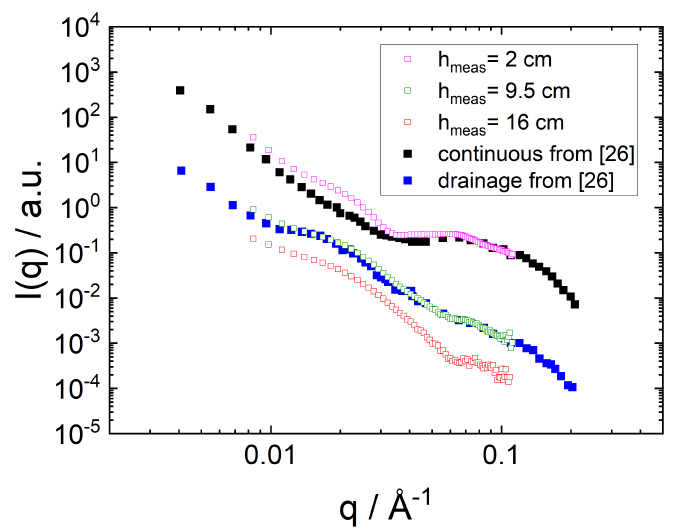
Figure 7. Radial averaged scattering data from a 25gL − 1 SDS foam (86.7mM) at three different foam heights in a steady-state foam (open symbols) and comparison with reference data of a wet continuous foam and a foam after drainage